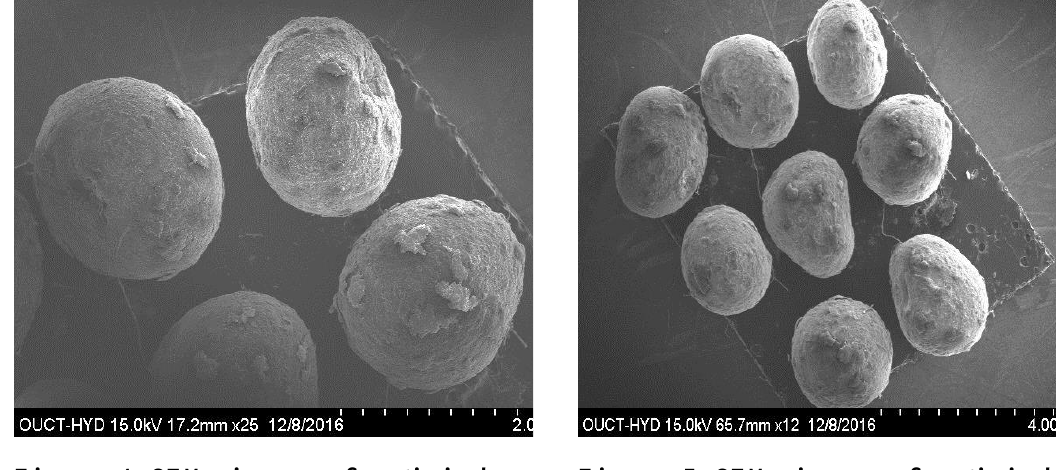
Figure. 5 SEM images of optimized formulation